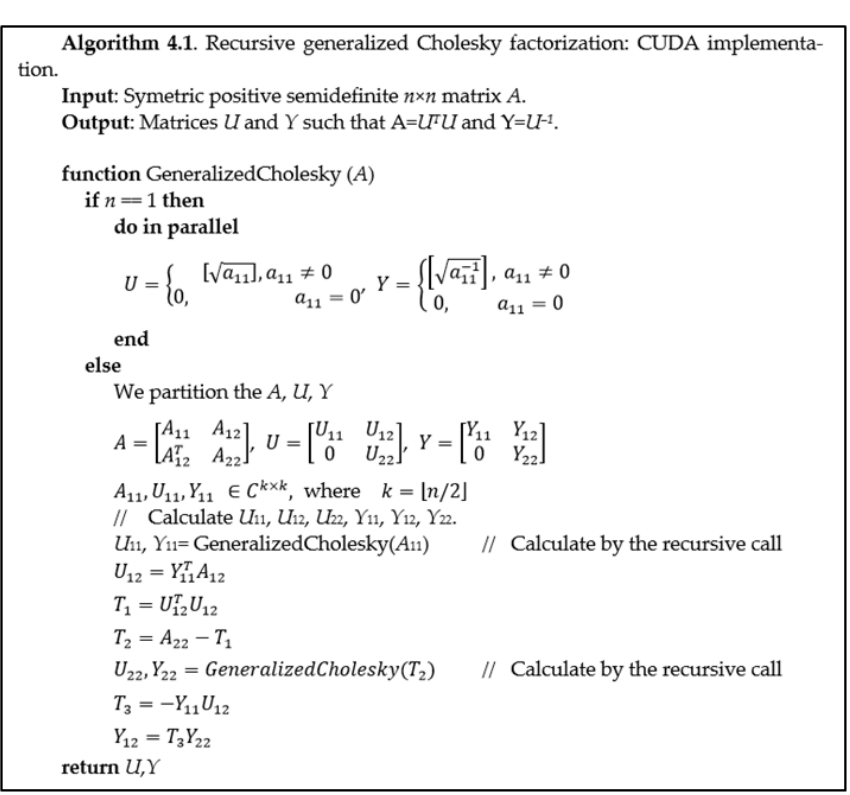
Figure A1. Generalized Cholesky factorization: CUDA implementation.